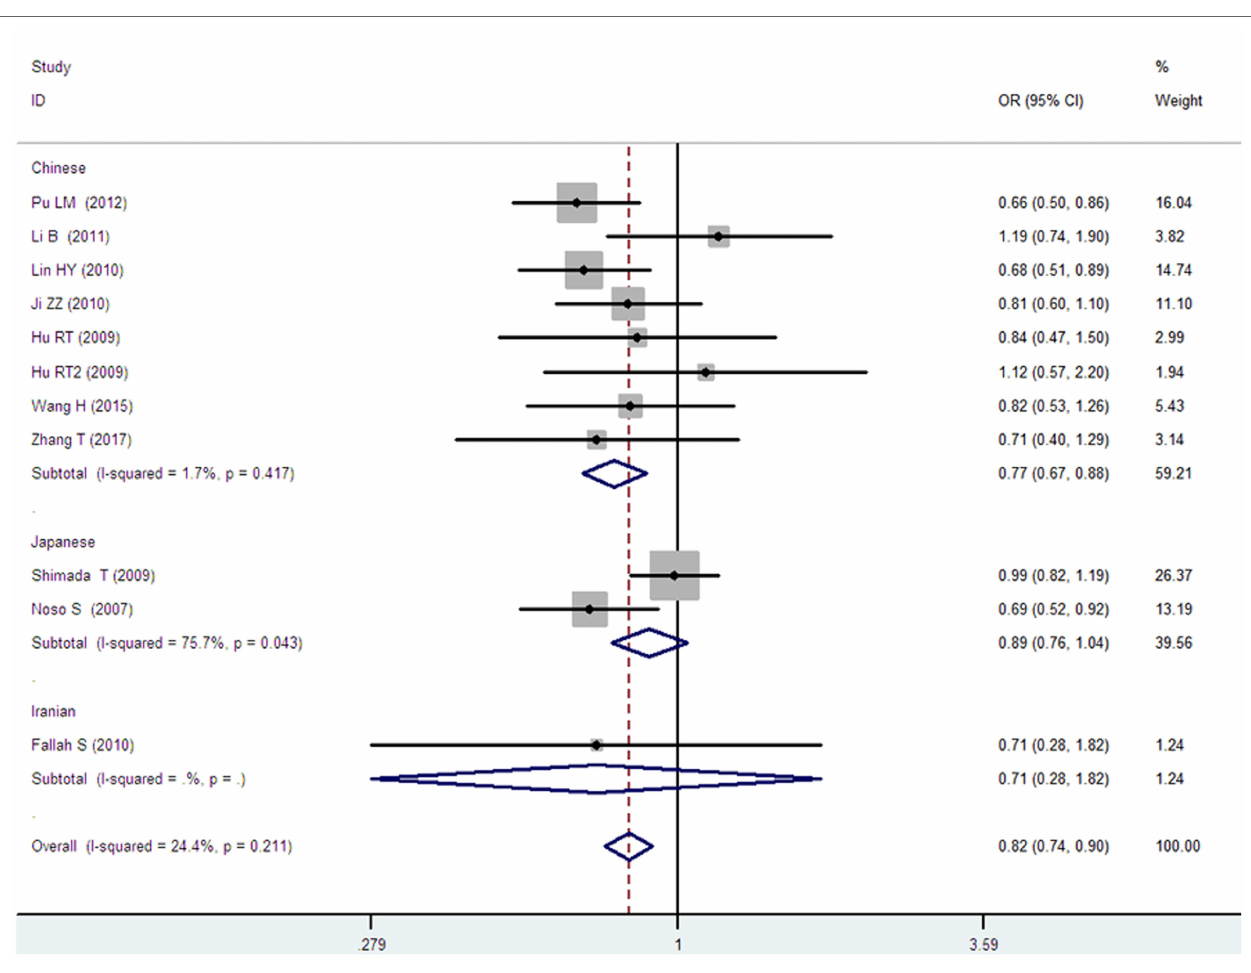
FigUre 3 | Forest plot of type 2 diabetes mellitus associated with small ubiquitin-like modifier 4 gene M55V polymorphism under a dominant genetic model (MM vs. MV +